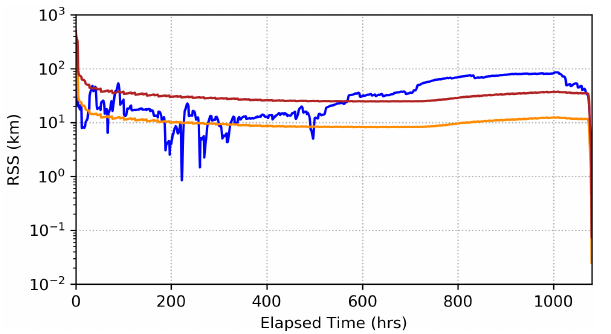
Figure 18. Position error (blue) and RTPC uncertainty (1- σ (orange) and 3- σ (red)) for radiometric-only filter with attitude thruster mis-modeling.